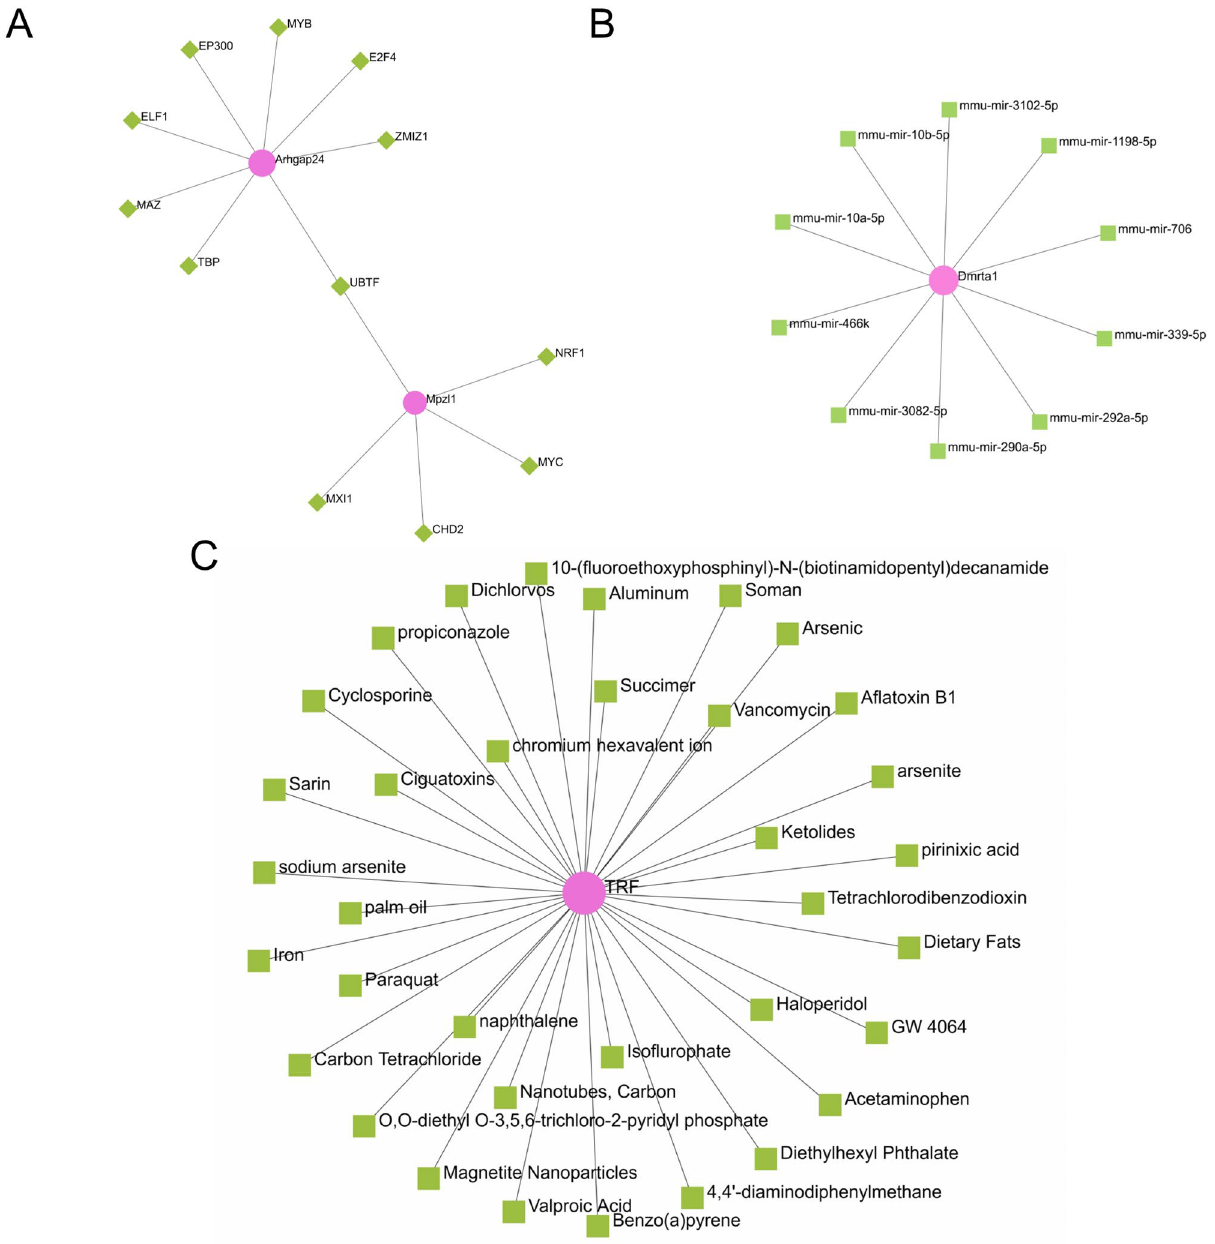
Figure 6. NetworkAnalyst analysis of common DEGs: ( A ) Gene-mirNA coregulatory network, pink represents genes and green represents mirnas. ( B ) Gene identification of TF-Gene Interactions. Pink represents genes and green represents transcription factors. ( C ) Protein-chemical Interactions of common DEGs. Pink represents genes and green represents drugs.